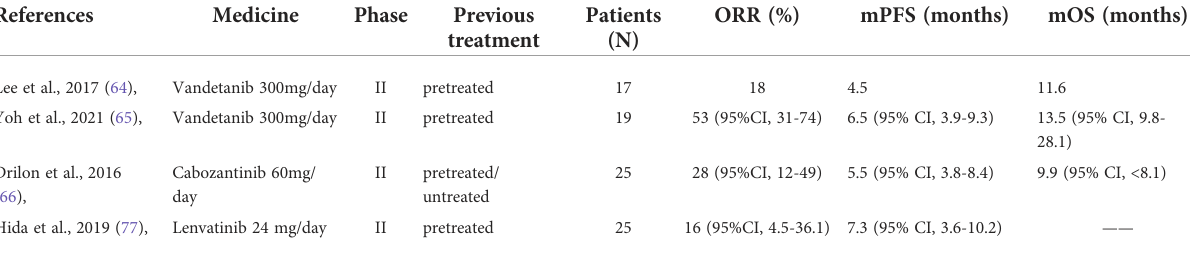
TABLE 3 Non-selective inhibitors in RET+NSCLC